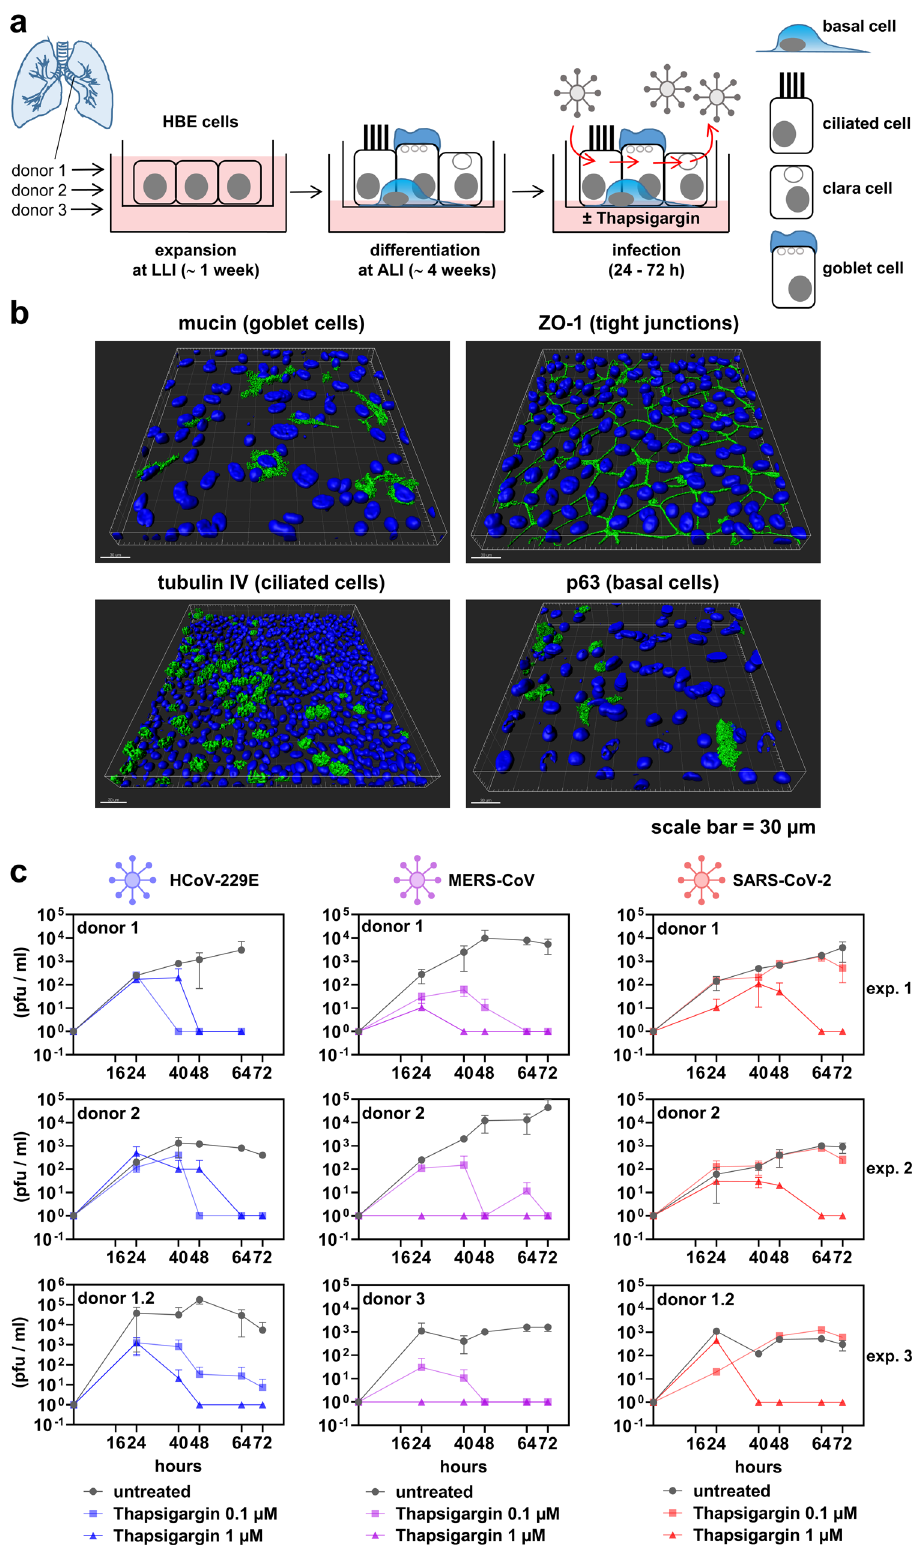
These (variable) antiviral effects of ba fi lomycin A 1 are in line with other alkylating agents that suppress lysosomal pathways 54 . Ba fi lomycin A 1 and thapsigargin strongly increased the appear- ance of p62/SQSTM1-positive foci representing autophagosomes in untreated but also in infected cells, suggesting that HCoV-229E